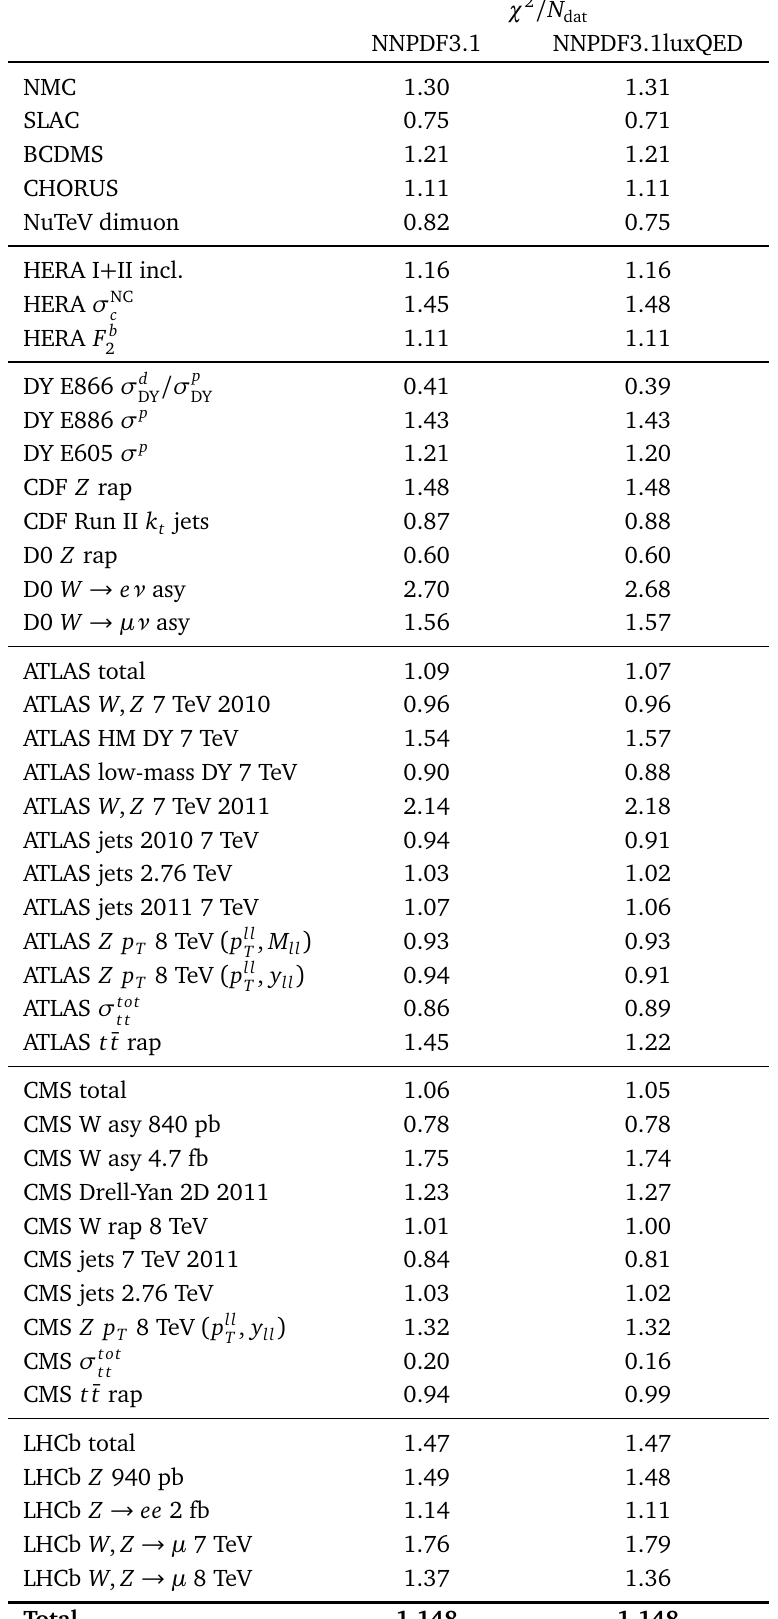
Table A.1: The values of χ 2 / N all the experiments included in the global analysis. These χ 2 / N using the experimental